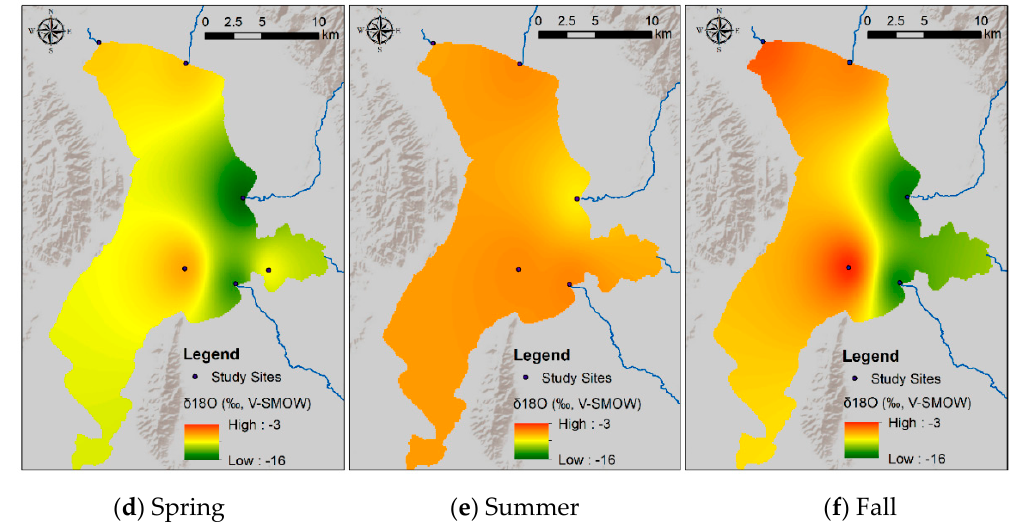
Figure 8. Spatial variability in the δ 2 H ( a – c ) and δ 18 O ( d – f ) values of Utah Lake surface water samples collected in the spring, summer, and fall 2015. The δ -values were modeled using the inverse distance weighted interpolation spatial analysis method in Arc-GIS. The δ -values vary significantly over the lake surface (particularly in the spring and fall), suggesting that the lake is poorly mixed horizontally.